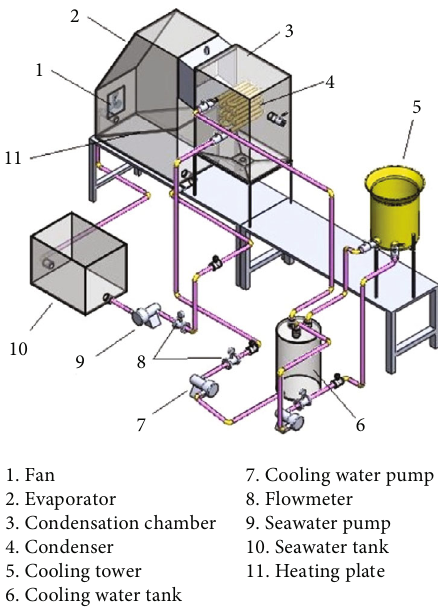
Figure 2: 3D fi gure of the small-scale solar humidi fi cation- dehumidi fi cation seawater desalination system combined with the